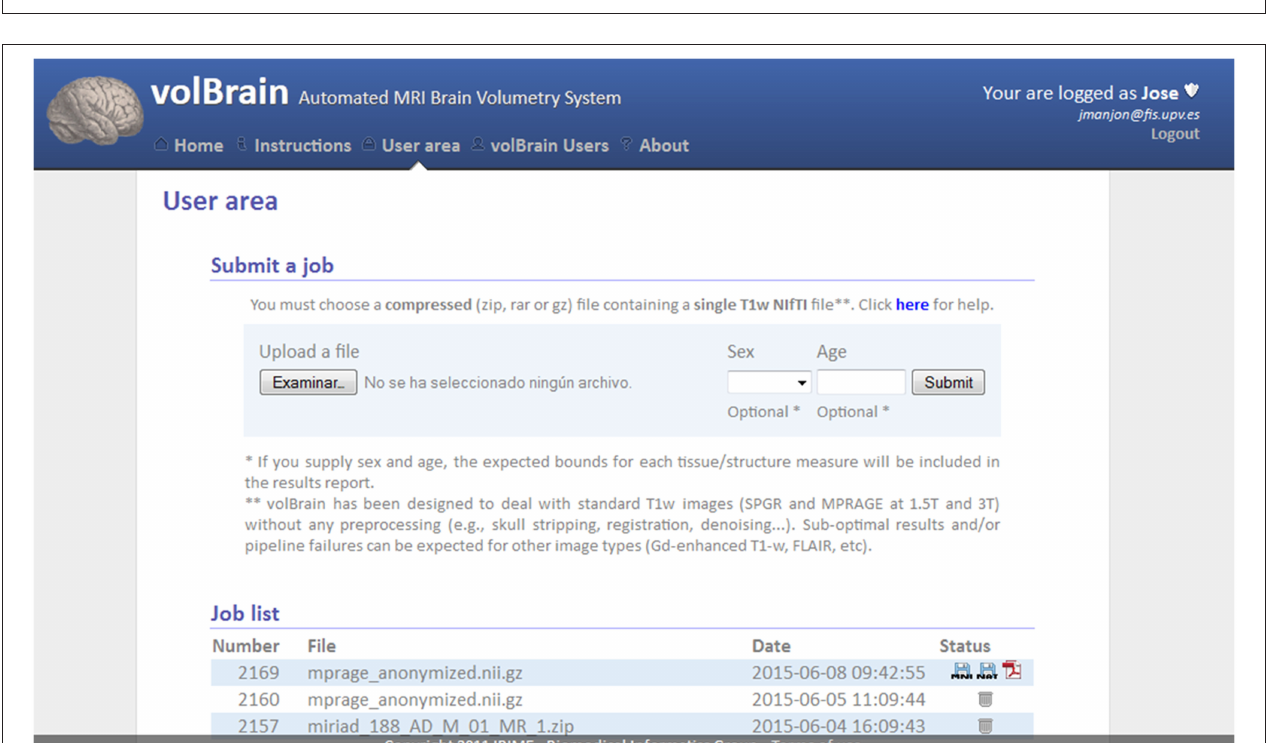
FIGURE 3 | Capture of volBrain website user area. Here the user can submit a new case and download the results of previous cases.